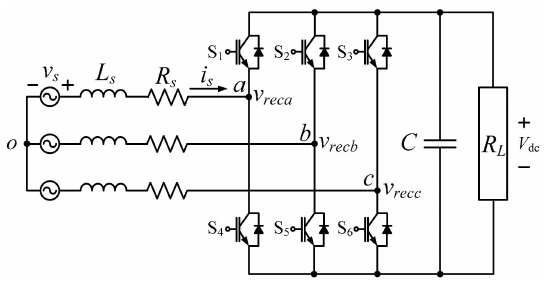
Figure 1. Three-phase rectifier.